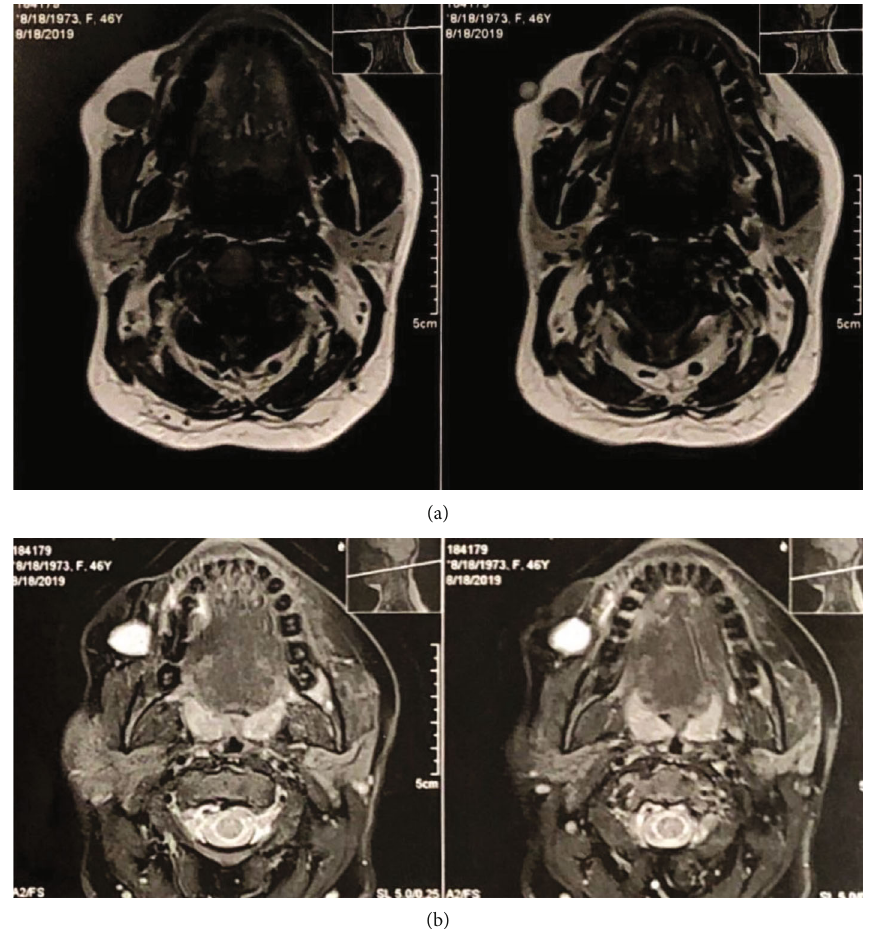
Figure 3: (a) Axial T1 MRI shows a low signal homogenous mass in the right lying over the buccinator muscle and under the skin. (b) Axial T2 MRI shows the lesion as high signal and homogenous.